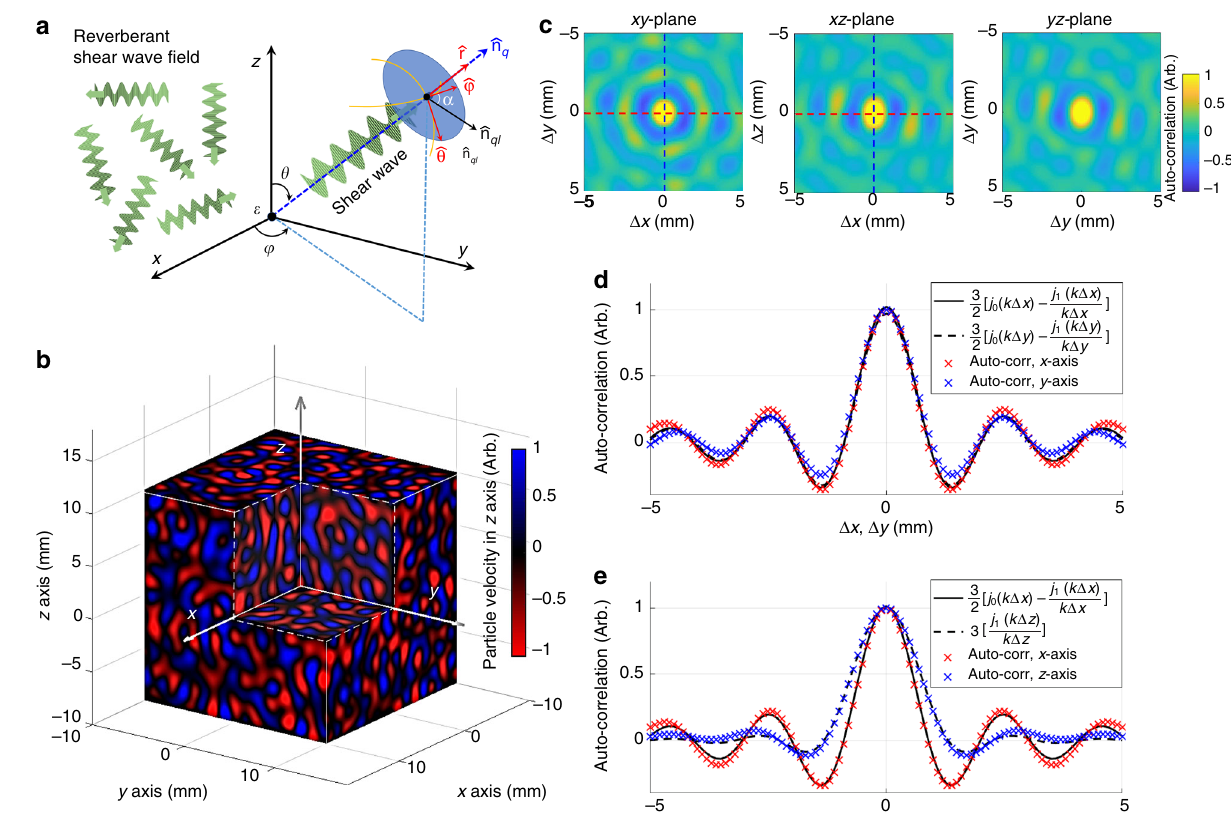
Fig. 1 Principles of reverberant fi elds in elastic media. Underlying principle of Rev3D-OCE and theoretical predictions of the auto-correlation function in a reverberant fi eld. a Graphic illustration of a shear wave reverberant fi eld modeled as a superposition of plane shear waves traveling in a random direction ^ θ and ^ φ , and a particle velocity random amplitude v ^ n ^ n q , with perpendicular particle velocity ql parallel to the plane (blue disk) formed by basis vectors ql . b Particle velocity fi eld along z -axis V z ε ; t 0 ð Þ at instant t 0 in a cube of 20 × 20 × 20 mm 3 of uniform elastic material after conducting a Monte Carlo analysis of reverberant shear waves with frequency of f 0 = 2 kHz, and a constant shear wave speed c 4 ms (cid:3) 1 after a total of 10,000 realizations of all random s ¼ variables. c Real part of 2D auto-correlation maps extracted from the reverberant volume V z ε ; t 0 ð Þ in ( b ) taken in three planes: xy -plane, xz -plane, and yz - plane. Colorbar represents normalized auto-correlation in arbitrary units. In ( d ) and ( e ), auto-correlation pro fi le cuts in both axis extracted from ( c ) in the xy -plane and xz -plane, respectively, are plotted with analytical Eqs. (2) and (3) for further comparison. Auto-correlation pro fi les plots in yz -plane are similar to xz -plane since both x and y axes are perpendicular to measurement axis ^ e z